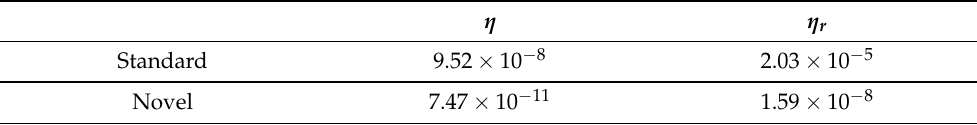
Table 1. Error between RHS and